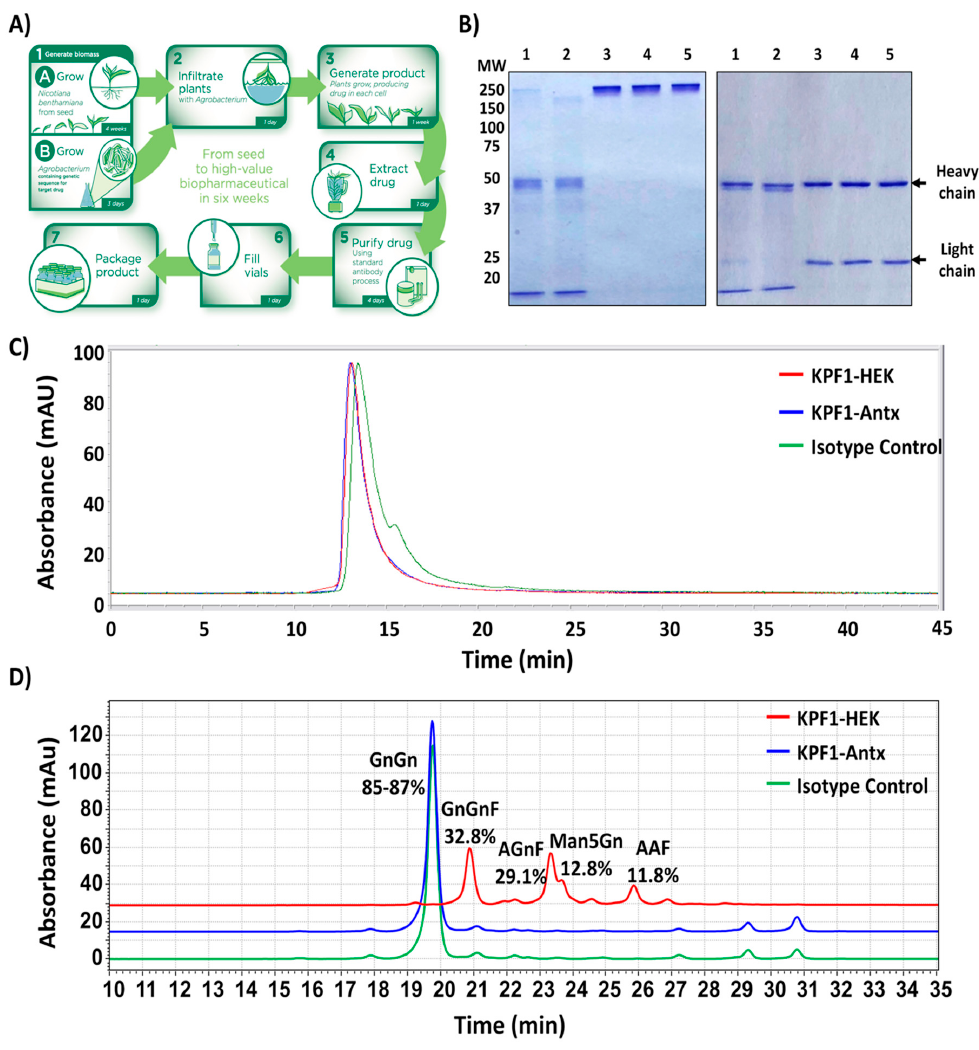
Figure 1. Production and characterization of the KPF1-Antx hMAb. ( A ) Schematic representation of KPF1-Antx hMAb production using the vivo XPRESS ® platform. Four week old plants were